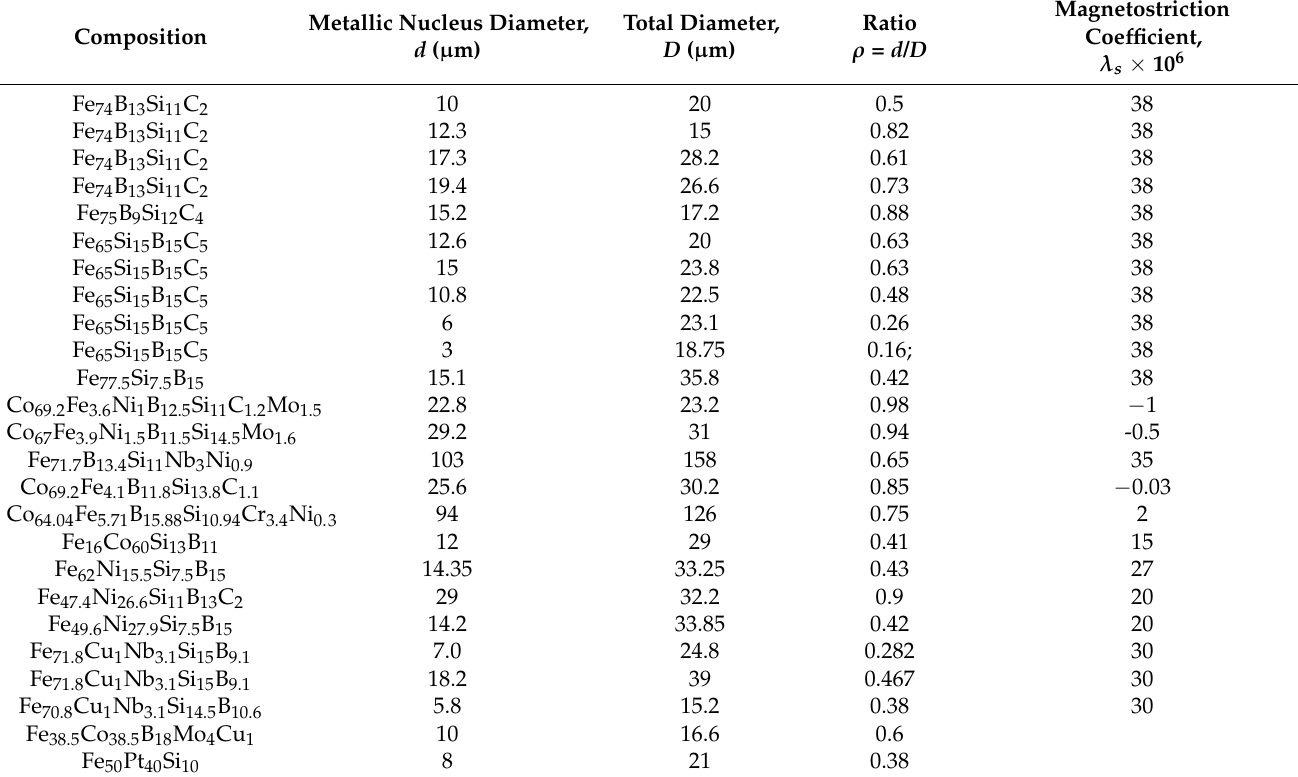
Table 1. Compositions and geometry of studied glass-coated